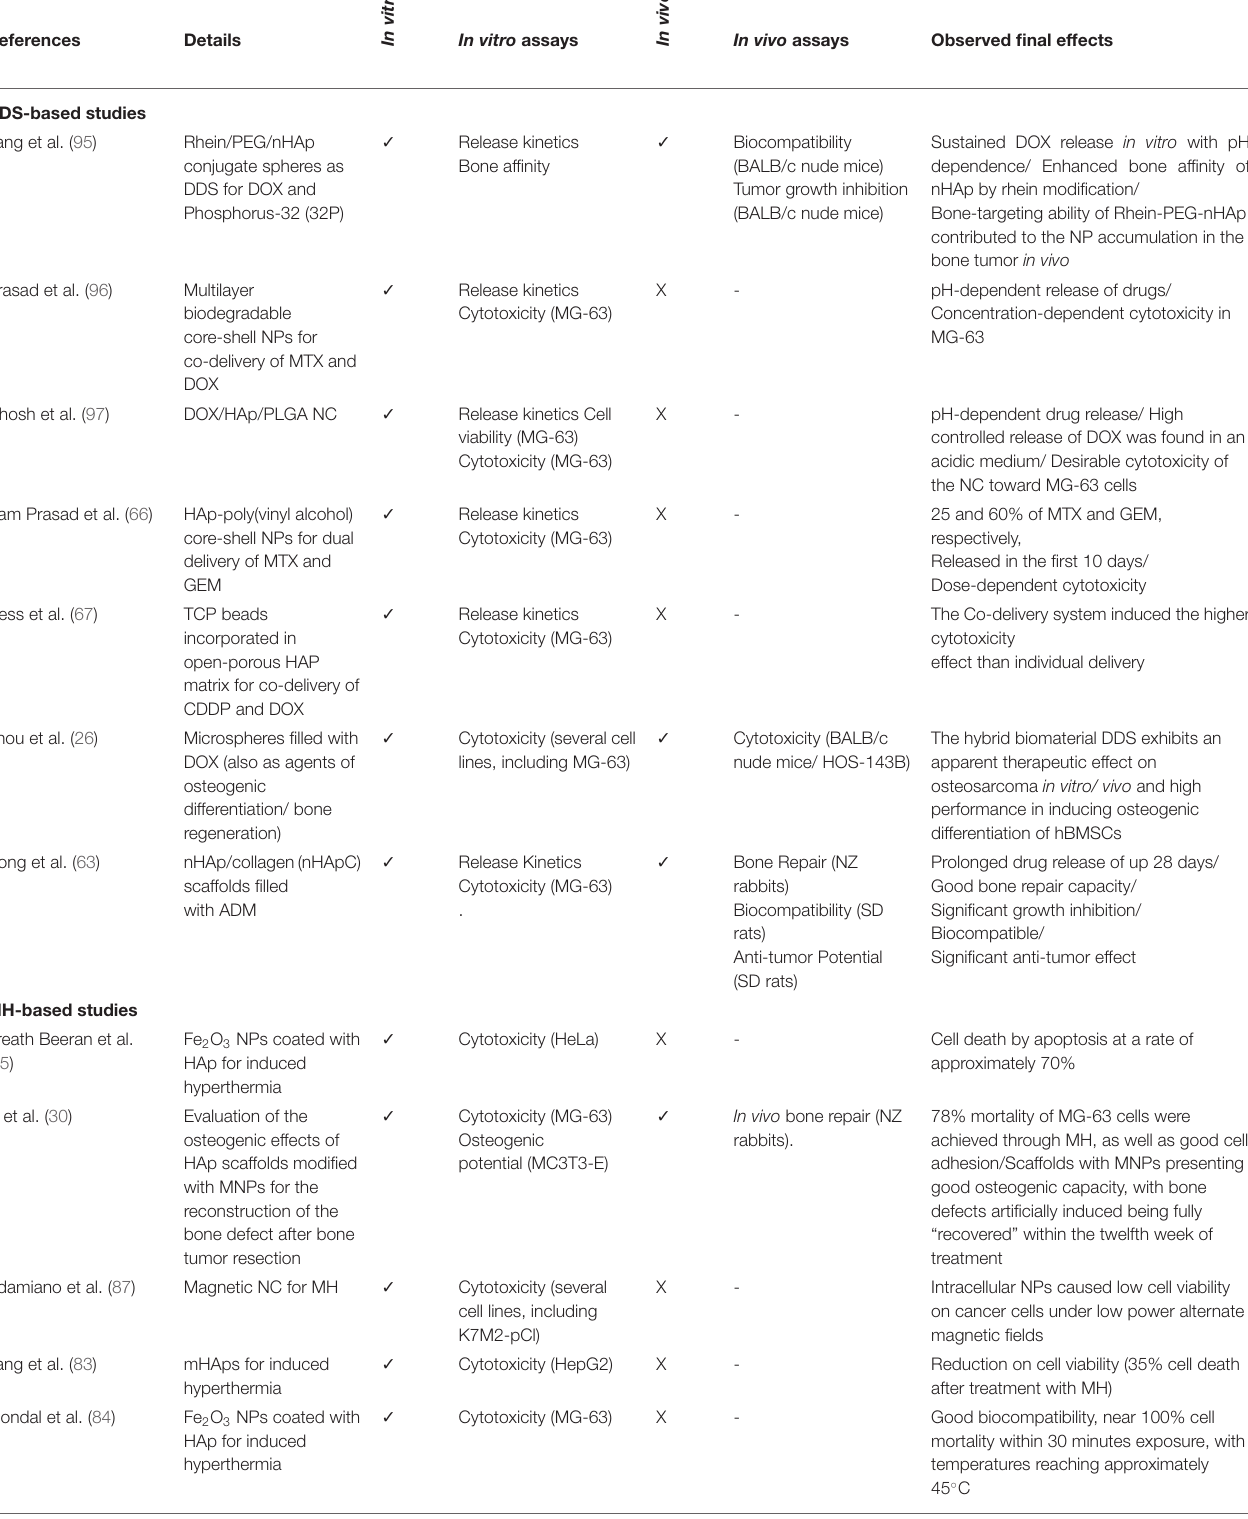
TABLE 1 | Summary of studies investigating different bioceramics-based strategies for the treatment of